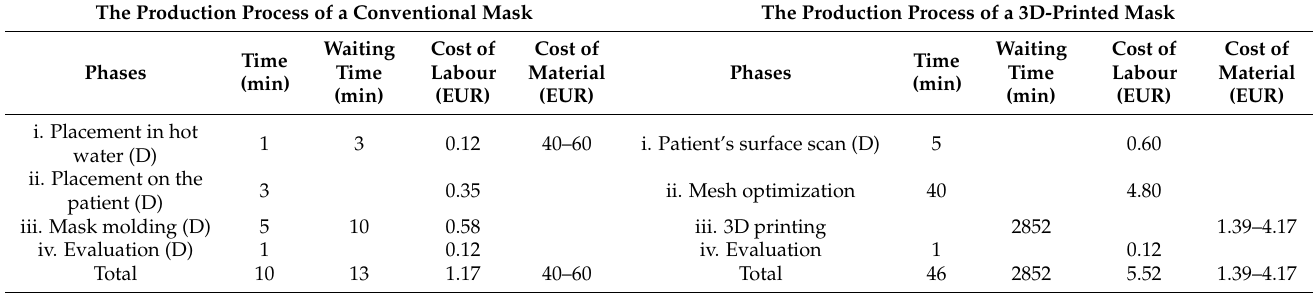
Table 6. Summary of the conventional production process and the proposed production process with the requirements of time and cost of material and